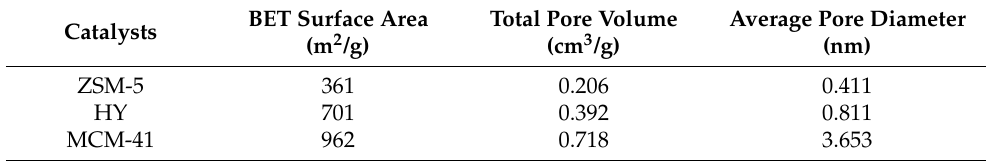
Table 1. Textural properties of different catalysts.